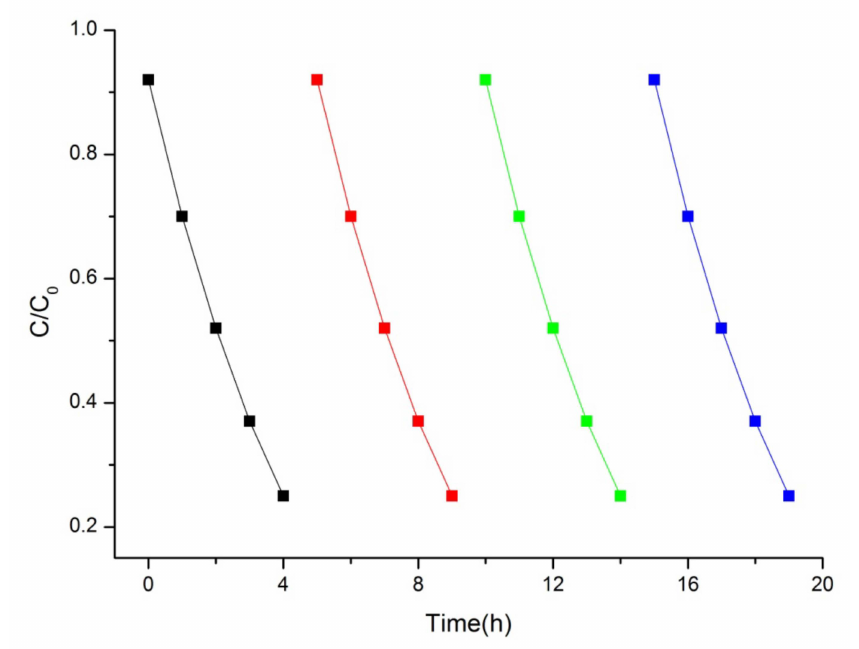
Figure 8. Cyclic photocatalytic activity of MB by Bi 2 Mo 2 O 9